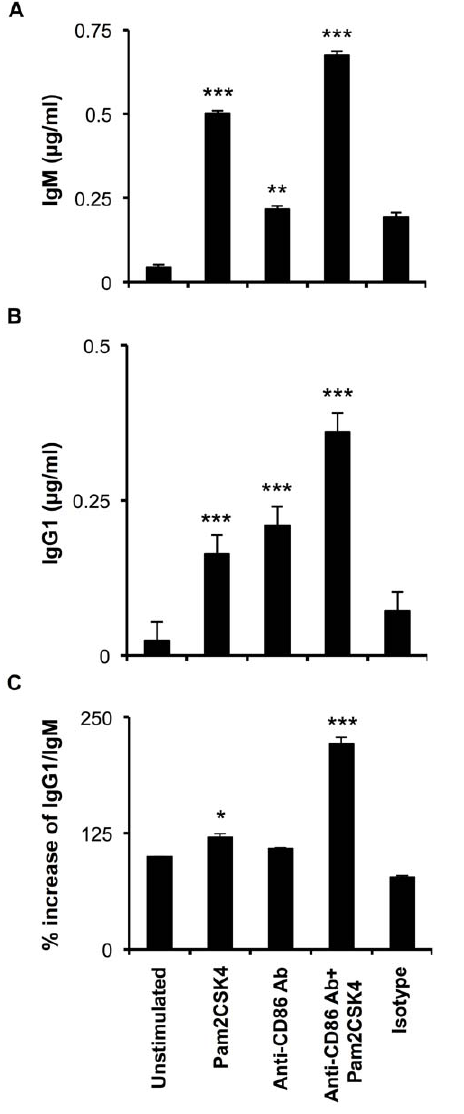
Figure 4. CD86 show synergism with TLR-2 in augmenting the secretion of IgM and IgG1 and class switch recombination. (A, B) Supernatants from 5–6 days old cultures of RB cells isolated from BALB/c mice and stimulated with anti-CD86 Ab and Pam2CSK4 were harvested and assessed for the production of IgM and IgG1 by sandwich ELISA. Data expressed as m g/ml represent mean 6 SEM of the triplicate wells were calculated with respect to standards. (C) Ratio of surface expression of IgG1 and IgM on RB cells stimulated with anti- CD86 or isotype antibody in the presence or absence of Pam2CSK4 for 16 h. Data are representative of 3–4 experiments. (A, B, C) Statistical analysis is done by non-parametric Mann-Whitney two tailed test and repeated measure ANOVA with post Student-Newman-Keuls multiple comparisons test by Graph Pad InStat 3 software. ‘p’ values are denoted with respect to unstimulated controls. ‘*’, ‘**’, ‘***’ indicates p , 0.05, p , 0.01, p , 0.001, respectively.